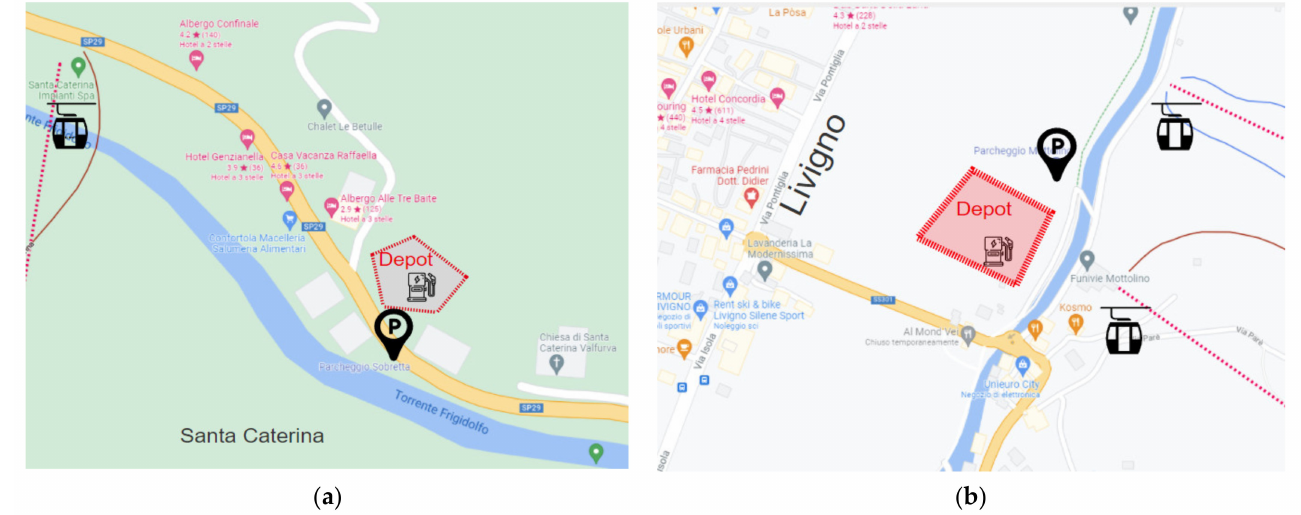
Figure 17. Bus Depot location proposed in ( a ) Santa Caterina and ( b ) Livigno through Google Earth.